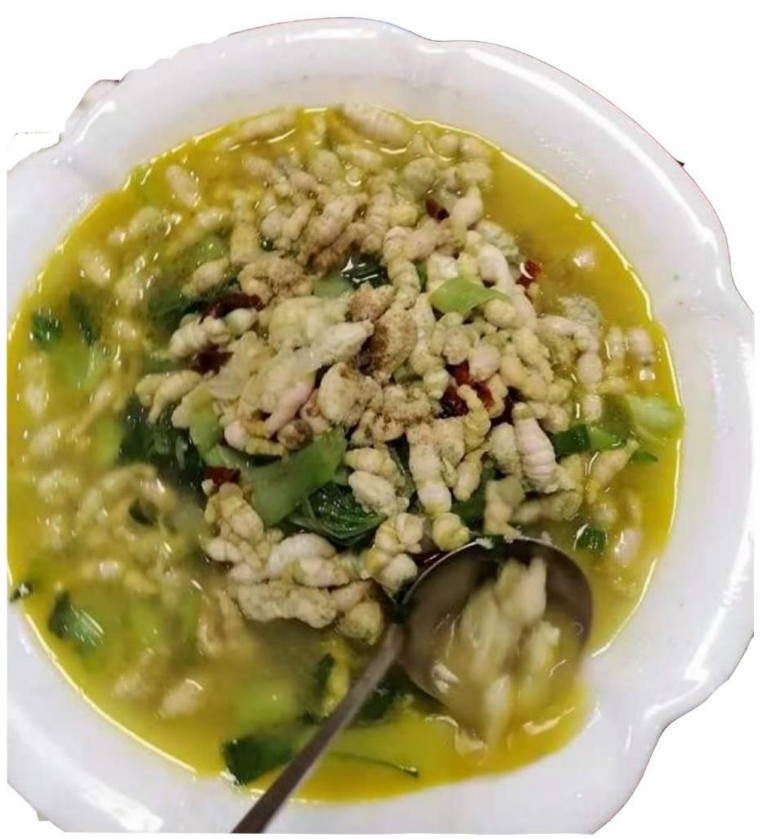
Figure 1. A common Clanis bilineata tsingtauica dish in a restaurant in Lianyungang City, Jiangsu Province. Clanis bilineata tsingtauica, whose larvae are also known as “Doudan ( 豆 丹 )” in China, feed as larvae on legumes, for example soybeans, among other plants [17]. In some years, this species can be a pest of soybeans. In nature, C. bilineata tsingtauica has 1 or 2 generations per year in China. In Jiangsu Province, there is 1 generation per year. There are 5 instars, 5th instar larva is around 8.15 g, and approximately 120 larvae weigh one kilogram. It